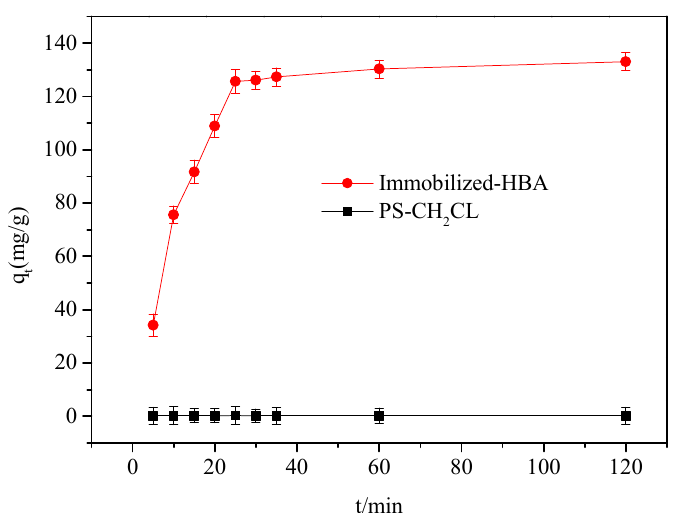
Figure 3. The adsorption kinetic curve of arbidol by the immobilized-HBA and PS-CH 2 Cl. Conditions: C arbidol = 300 mg/L, T = 20 °C, pH = 5.5.